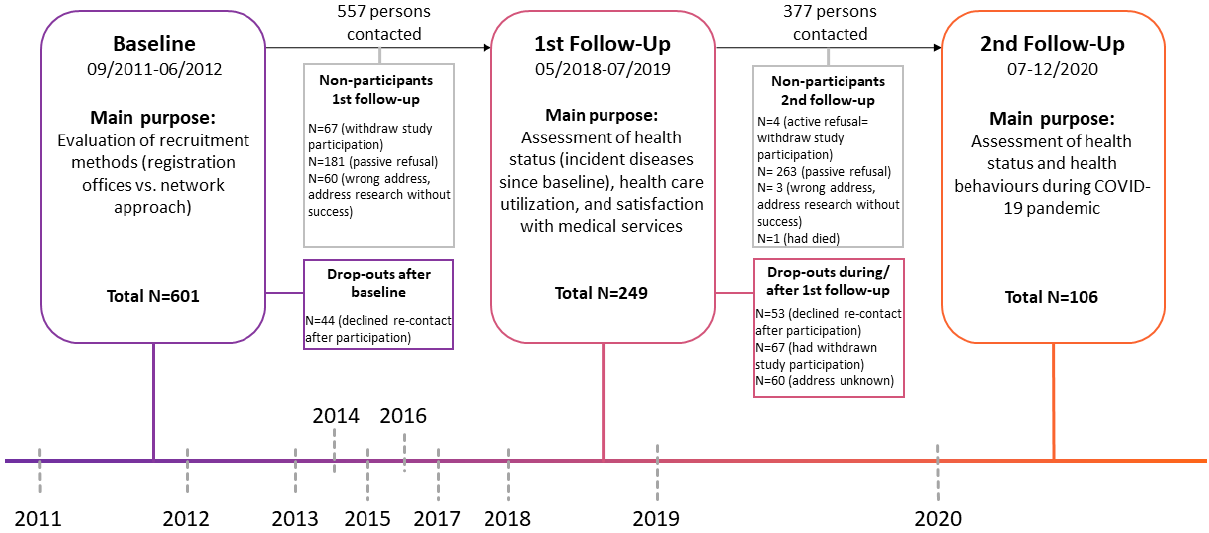
Figure 1. Recruitment process.